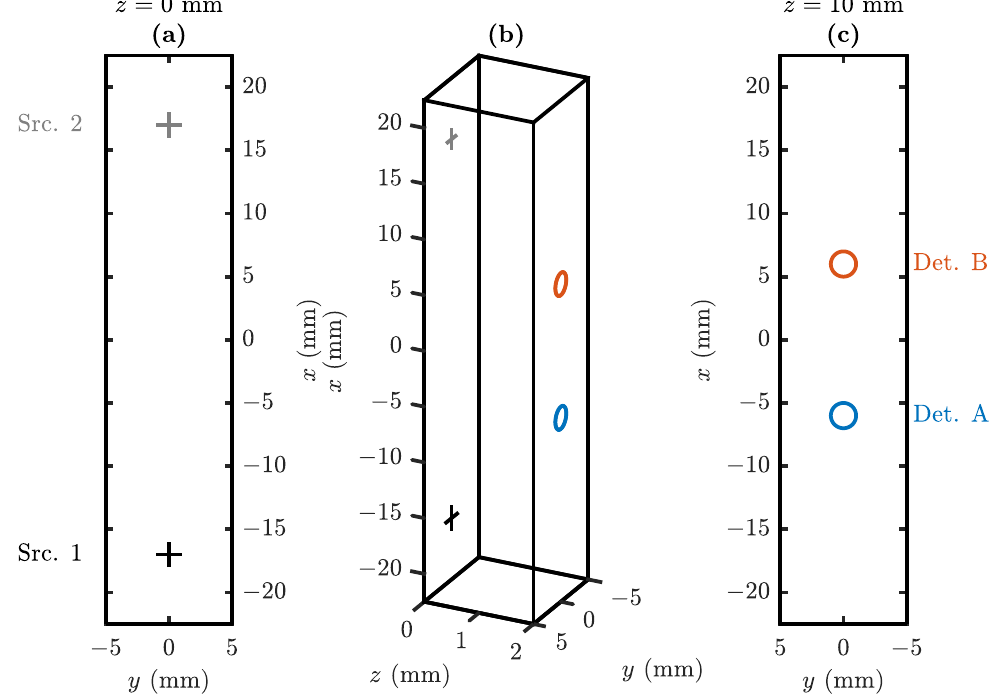
Figure 1. Schematic diagram of cuvette geometry measuring 45mm × 10mm × 10mm. Sources and detectors are considered at the following (cid:126) r s: (cid:126) r 1 = − 17 ˆ x mm, (cid:126) r 2 = 17 ˆ x mm, (cid:126) r A = − 6 ˆ x + 10ˆ z mm, and (cid:126) r B = 6 ˆ x + 10ˆ z mm. ( a ) y - x plane for z = 0mm. ( b ) Transparent projected view. ( c ) y - x plane for z = 10mm. Acronyms and Symbols: Position vector ( (cid:126) r